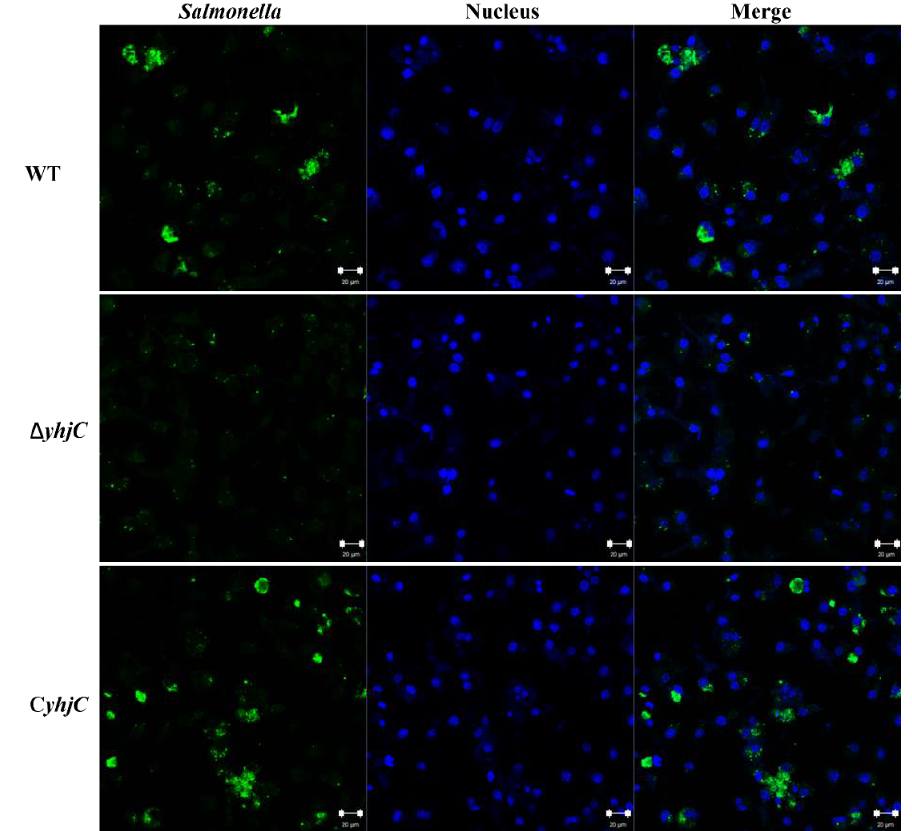
Figure 3. Representative images of RAW264.7 cells infected by WT, Δ yhjC , and C yhjC bacteria at 16 hpi. Bacteria were labeled with anti- Salmonella antibody (green), and cell nuclei were stained with 4′,6 -diamidino-2-phenylindole (DAPI, blue).